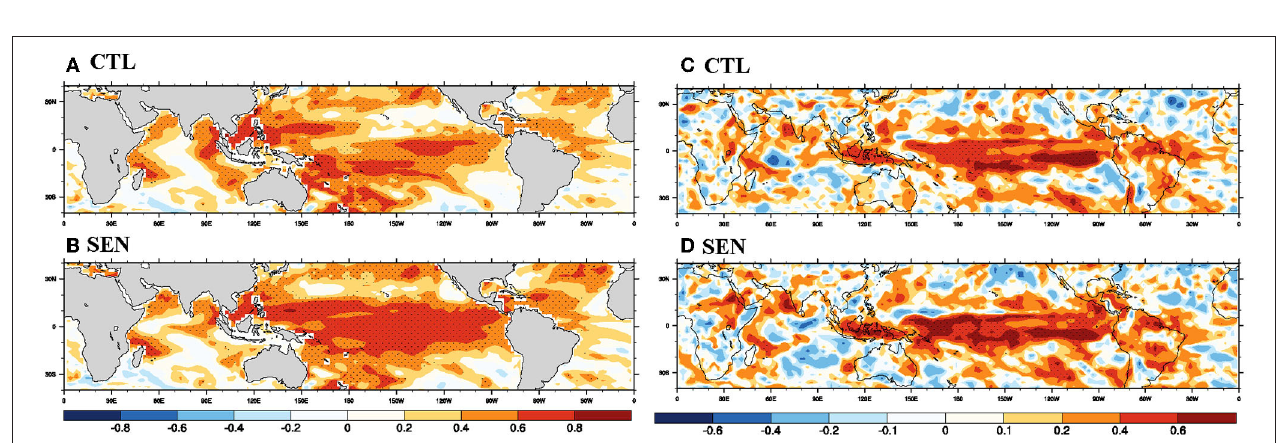
FIGURE 12 | Prediction skill in terms of anomaly correlation coefficient (ACC) for SST during JJAS in (A) CTL run, (B) SEN run for the period of 1981–2017. (C,D) same as (A,B) , but for precipitation.